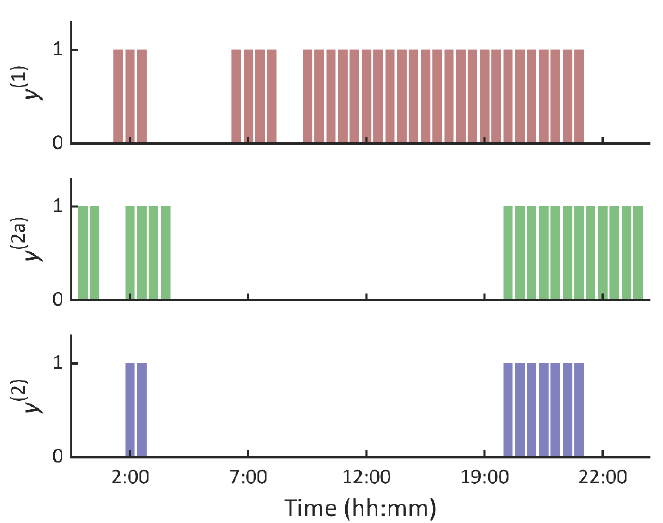
Figure 8. The value of the variables 𝑦 (1) (top), 𝑦 (2𝑎) (middle) and 𝑦 (2) (bottom).